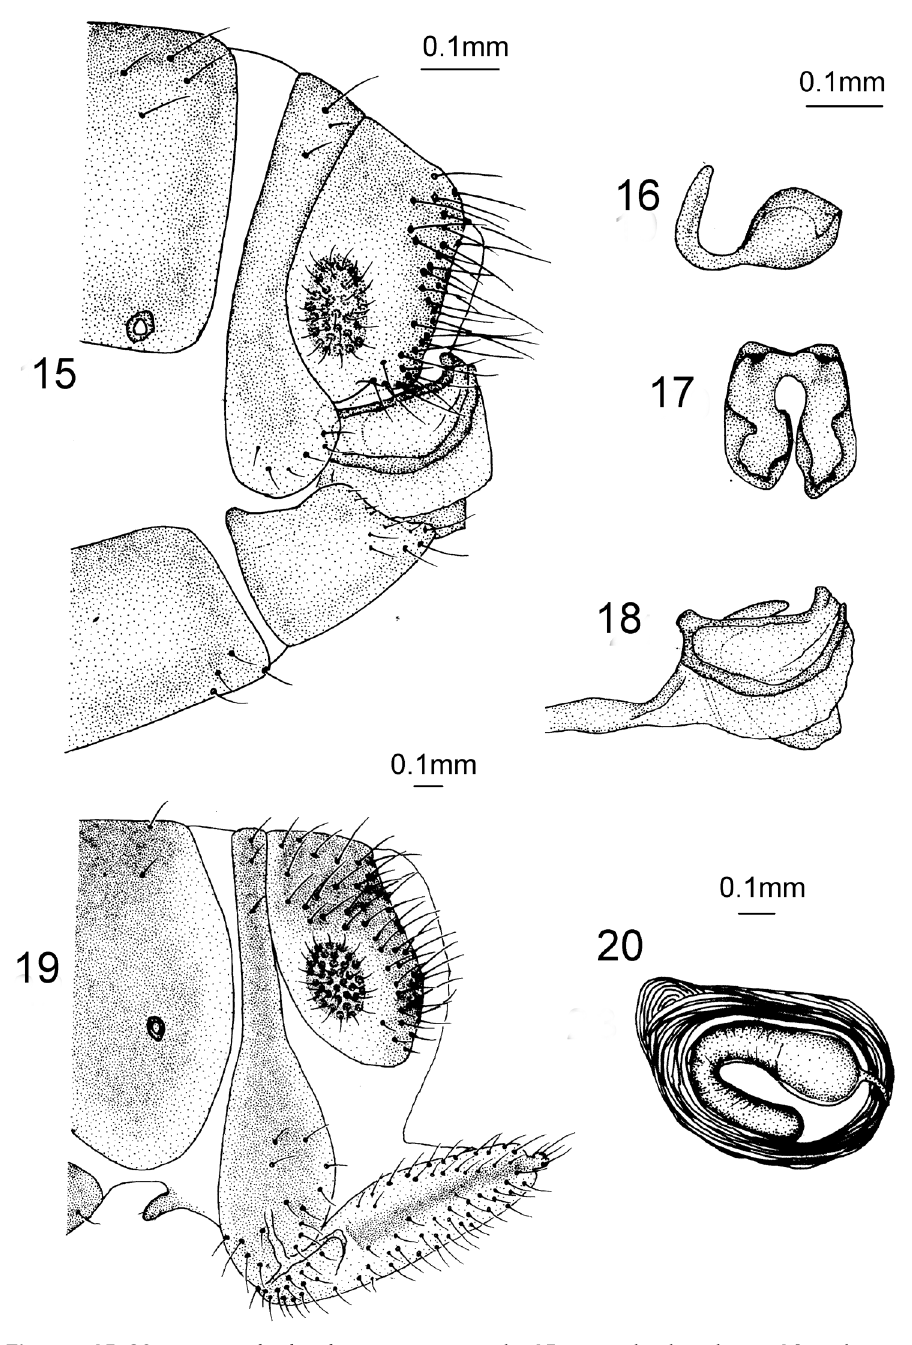
20 spermatheca, lateral